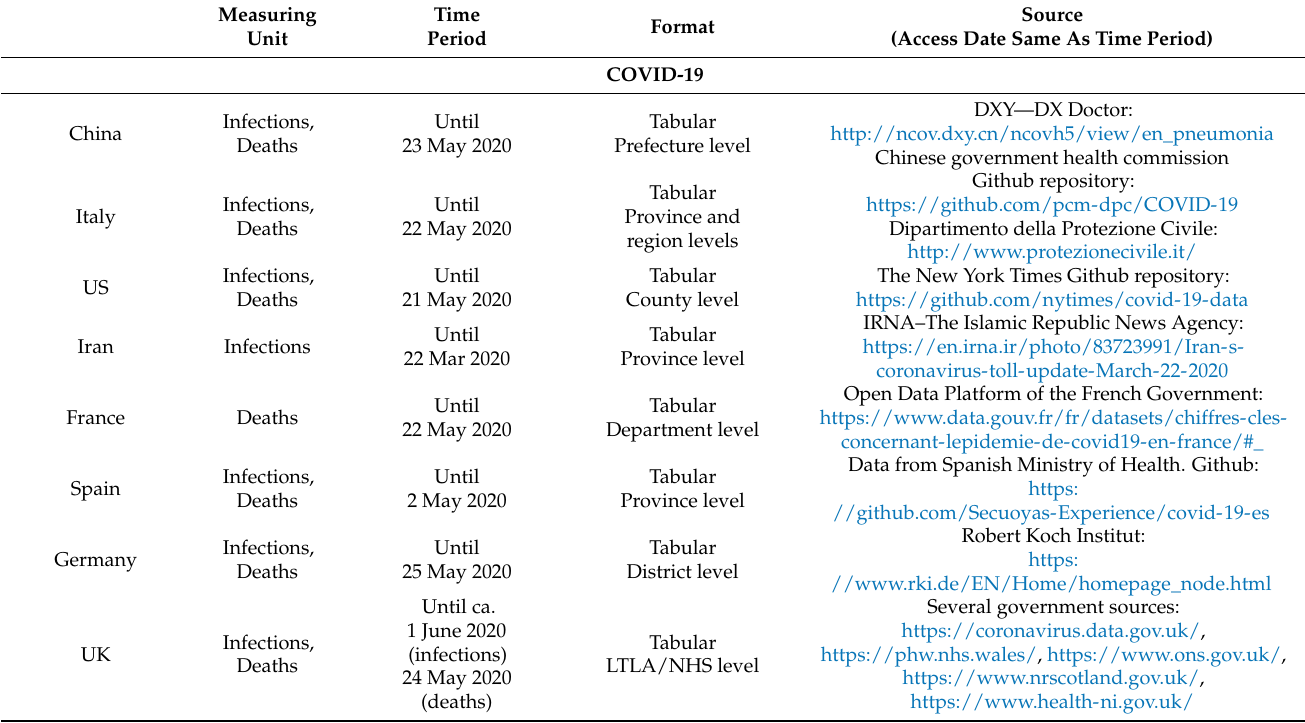
Table 1. Detailed information on the datasets used for the viral and pollution analyses. Measuring